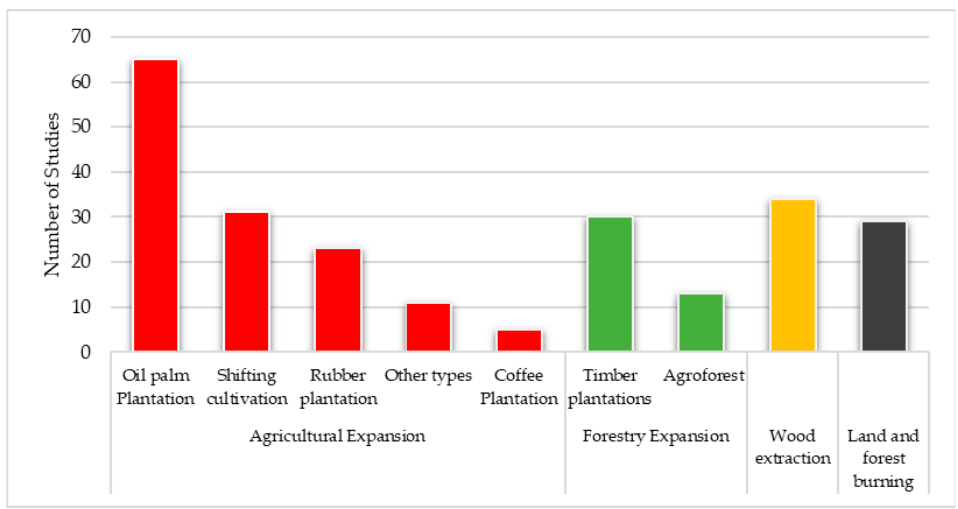
Figure 5. Diagram of direct causes of land change in Sumatra and Kalimantan.